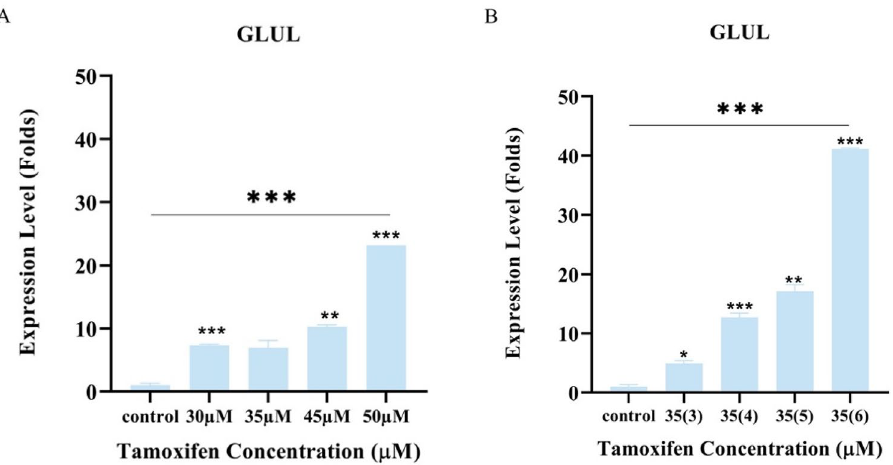
Figure 4. Levels of GLUL gene expression (Folds) during development of TAM-R. Gene expression analysis was performed as two independent runs, in each run; samples were analyzed as triplicate and folds increase was presented as ± SD. ( A ) using the first approach of tamoxifen resistance model and ( B ) using the second approach of tamoxifen resistance model. Comparisons were performed between the dose and the previous dose, and the last dose with the control untreated sensitive MCF-7 cells via one-way ANOVA. P* < 0.05, P** < 0.01, and P*** < 0.001.